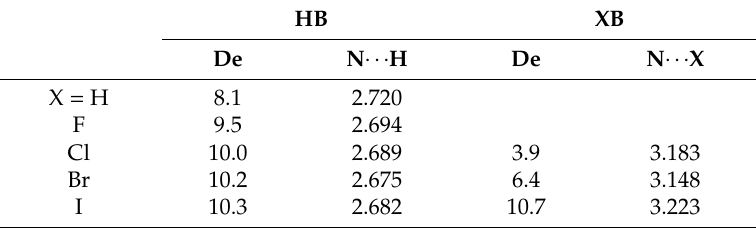
Table 4. Dissociation energy (kJ·mol − 1 ) and intermolecular distances (Å) of the C 6 H 5 X:NCH complexes.